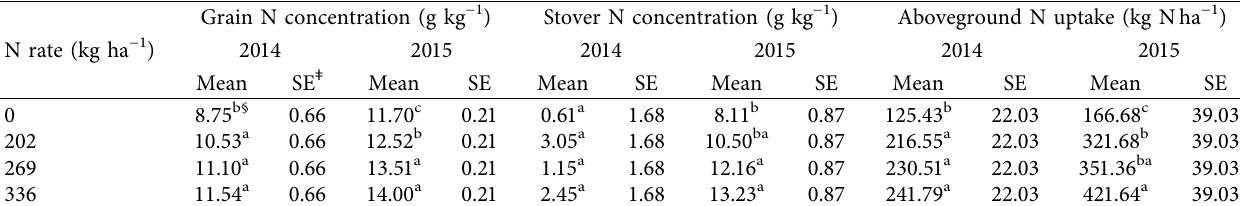
Table 7: Grain N, stover N concentrations and grain, and aboveground N uptake differences between years and N rates (0, 202, 269, and 336kg ha -1 ) at